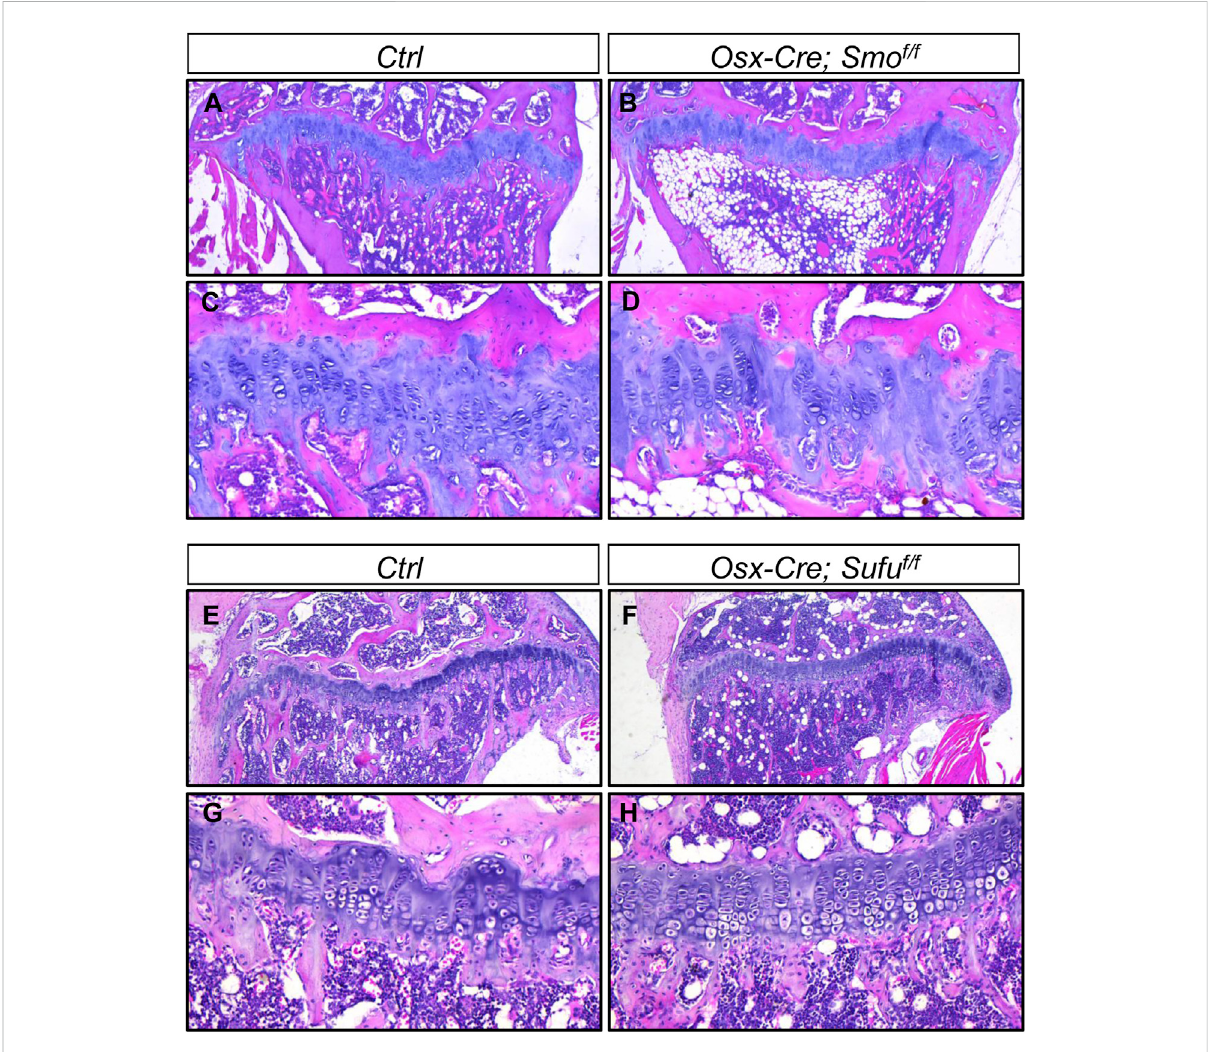
FIGURE 8 Osx-Cre -mediated ablation of either Smo or Sufu in hypertrophic chondrocytes did not overtly affect growth plates (A – D) H&E staining of the proximal tibial growth plates from P120 Ctrl (A,C) and Osx-Cre; Smo f/f mice (B,D) shown at low magni fi cation (A,B) and higher magni fi cation (C,D) (E – H) H&EstainingoftheproximaltibialgrowthplatesfromP90 Ctrl (E,G) and Osx-Cre;Sufu f/f mice (F,H) shownatlowmagni fi cation (E,F) andhigher magni fi cation (G,H)